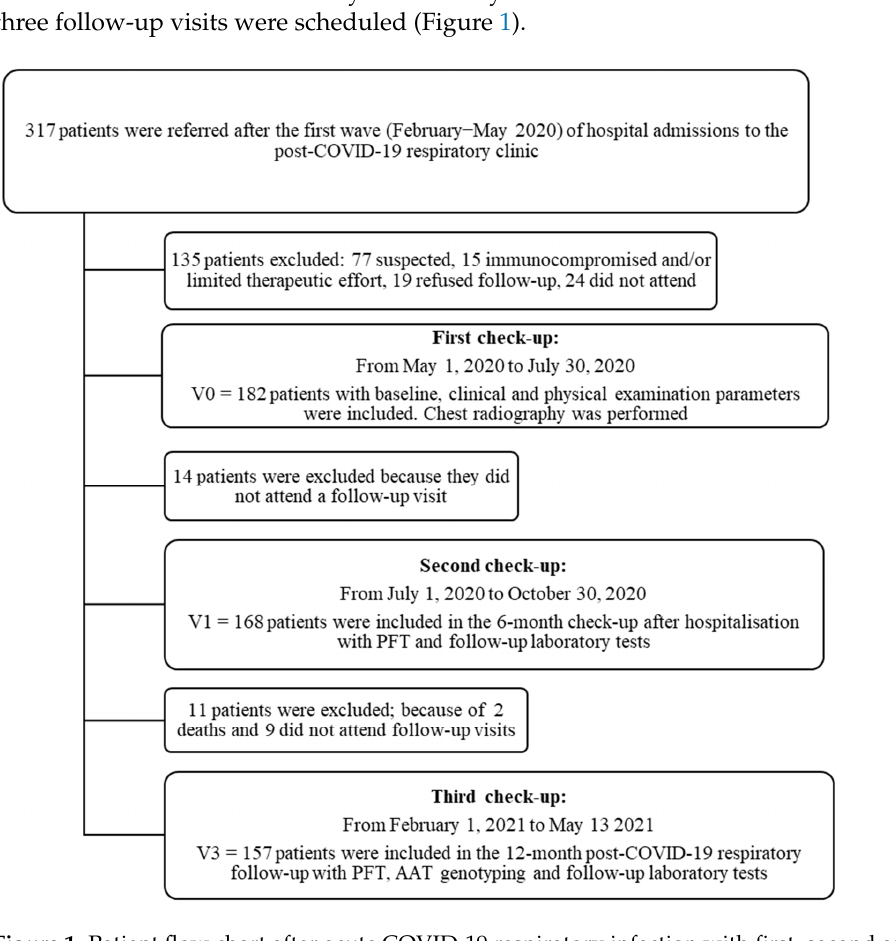
Figure 1. Patient flow chart after acute COVID-19 respiratory infection with first, second and third follow-up visits carried out at the University Hospital Virgen de las Nieves.